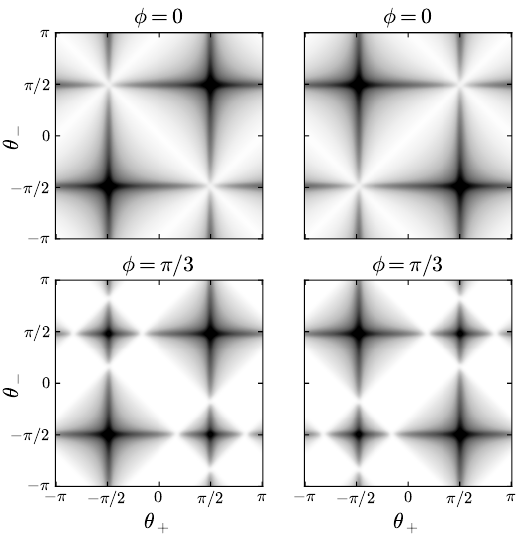
Figure 4: Inverse of the localization length Λ ( E ) = ξ − 1 , for E = 0 (first column) and E = π E (second column), and two values of the interaction phase φ = 0, π/ 3. The main effect of the interaction is to increase the area (white regions), in the parameter space ( θ + , θ − ) with diverging ξ (unlocalized states). Grey scales from white (zero level) to black ( Λ ( E ) =